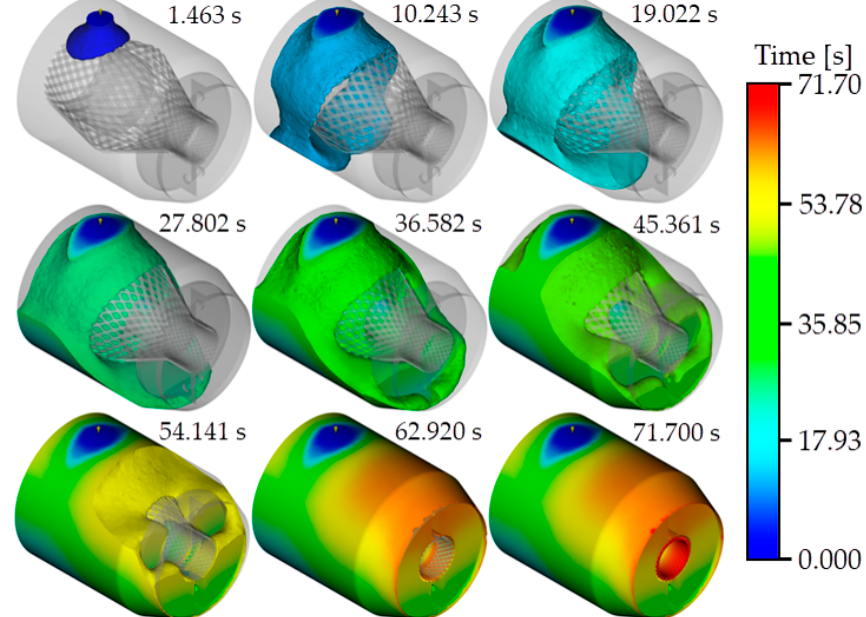
Figure 6. Resin filling process in the pouring simulation.